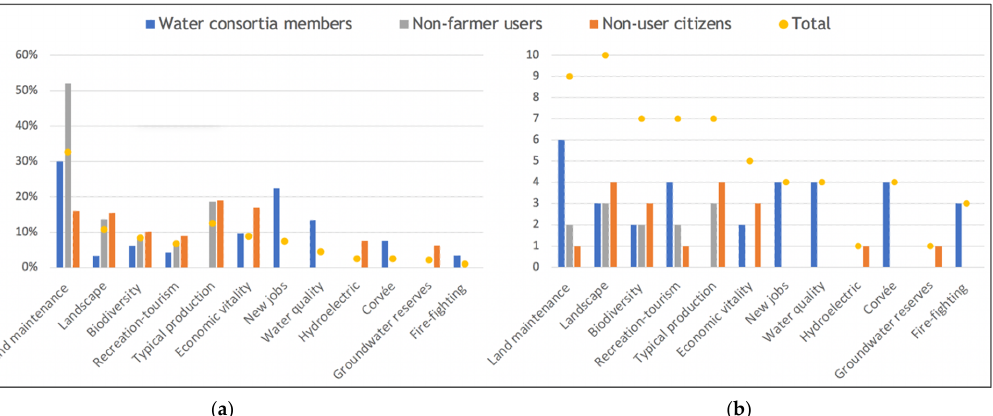
Figure 3. Discussion topics compared across different stakeholder types: ( a ) Spoken words on each topic (%); ( b ) participants involved in the discussion (n).